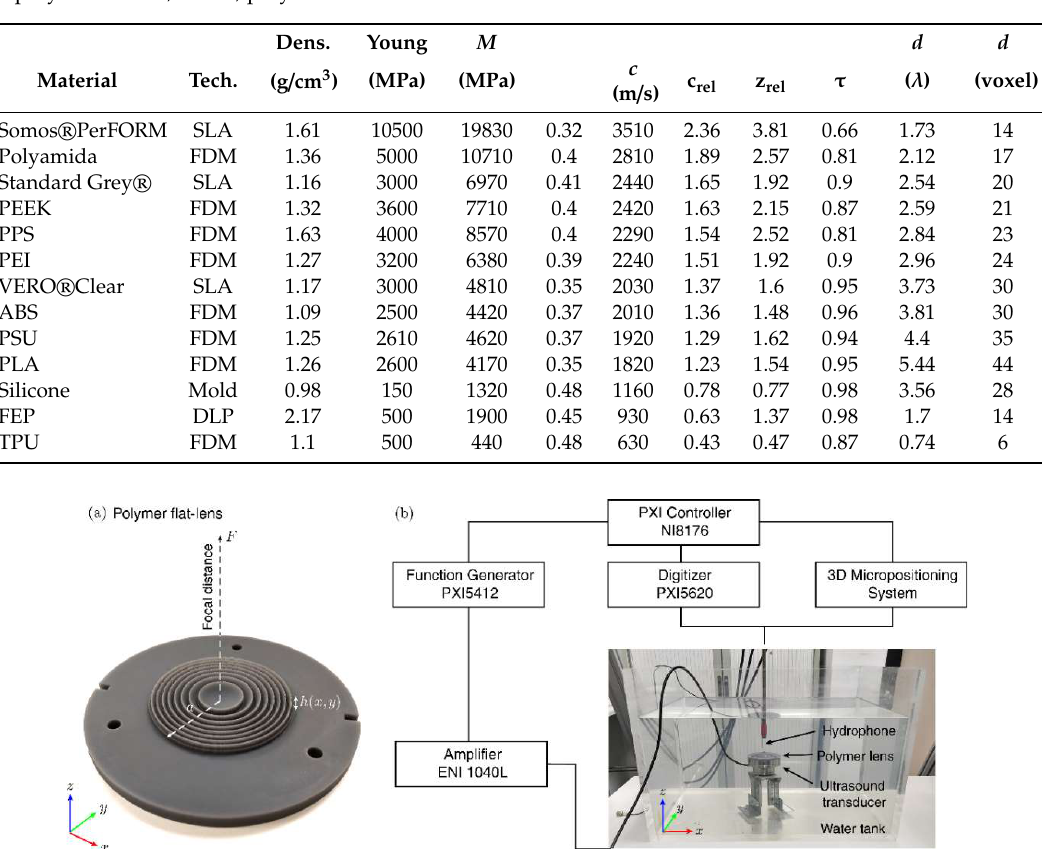
Table 1. Acoustical data of a series of 3D printable polymers, assuming for water c = 1485 m / s and z = 1485 krayl. The value τ represents acoustic transmission on a single layer lens / water. Nominal thickness, d , is obtained assuming a frequency of 760 kHz and a voxel size of 0.244 mm. SLA, stereolithography; FDM, fused deposition modelling; FEP, fluorinated ethylene propylene; PEI, polyetherimide; PEEK, polyetheretherketone.